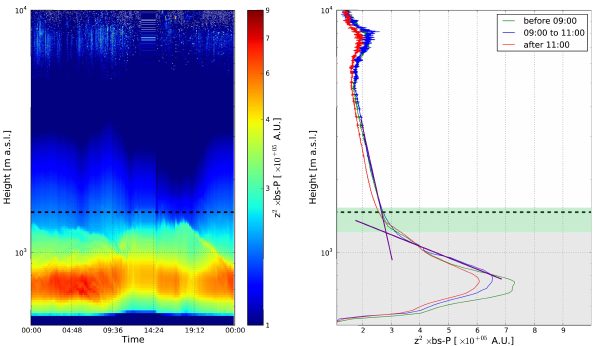
Fig. 10. Left panel: LIDAR z 2 -signal evolution in arbitrary units (13 March 2009). Right panel: average LIDAR z 2 -signal i- before 09:00 (green line), ii- between 09:00 and 11:00 (nucleation time) and iii- after 11:00. On both graphics, the black dot line represents the hight of the puy de Dˆome